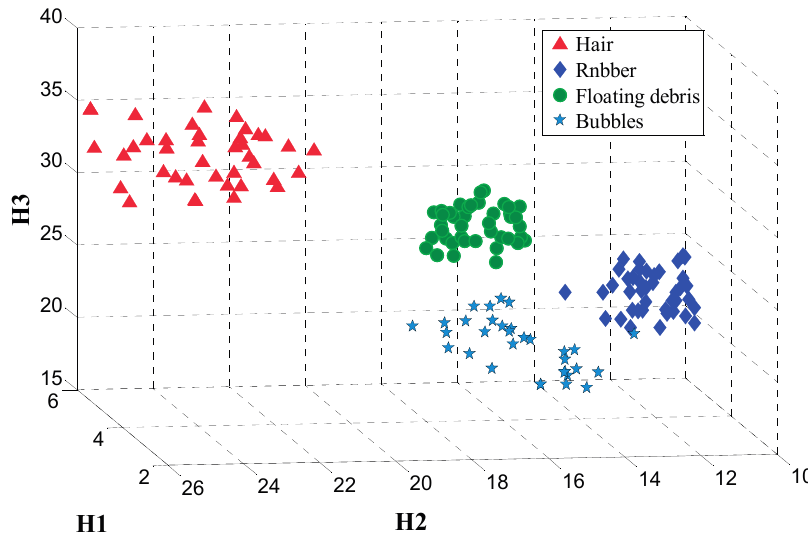
Figure 9. Spatial distribution of moving objects in the three-dimensional